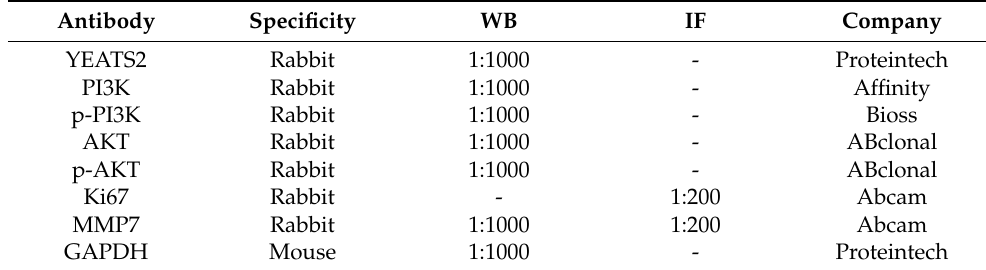
Table 1. All the primary antibodies used in the study. Antibody Specificity WB IF Company YEATS2